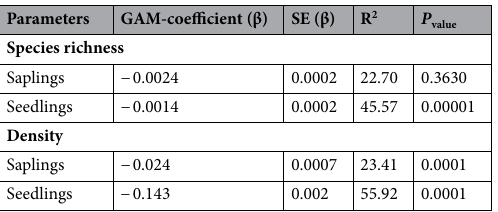
Table 5. Estimated changes in species richness and density of saplings and seedlings with respect to bamboo density in the Singalila National